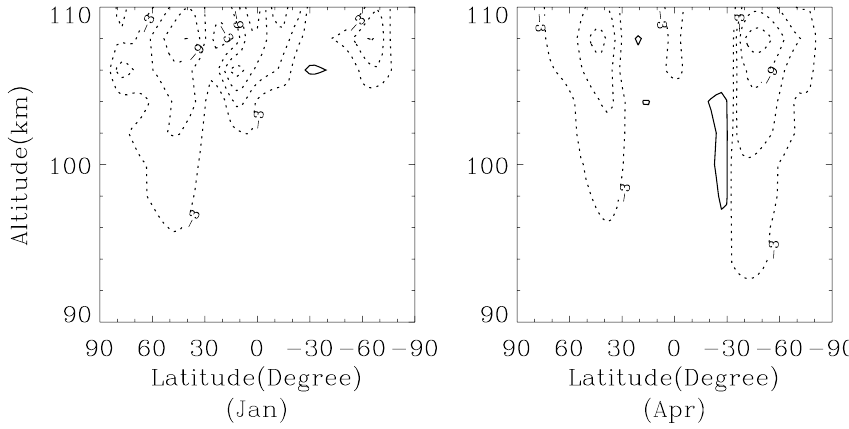
Fig. 9. Meridional-wind amplitude differences after 8 tidal periods for January (left) and April (right) deduced from the nonlinear propaga- tion solutions of the migrating semidiurnal tide starting from the GSWM-00 tidal oscillations. The intervals of the contours are 3ms − 1 . The solid and dotted curves denote the positive and negative values,